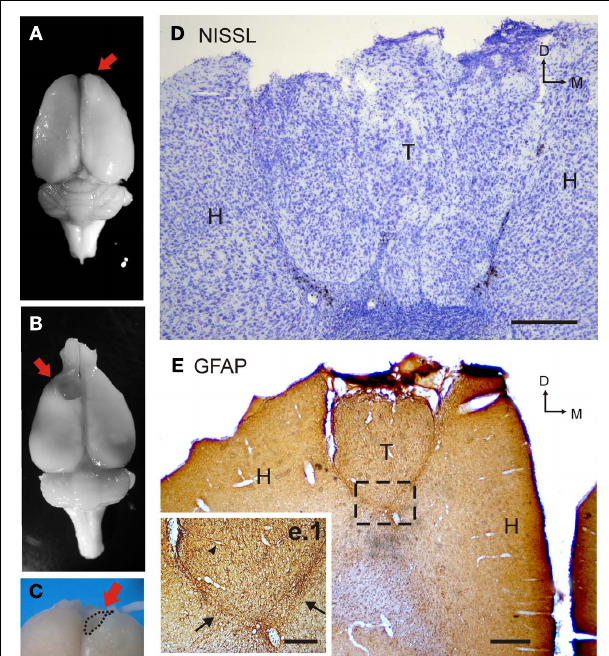
Table 1 | Sequences of primers for